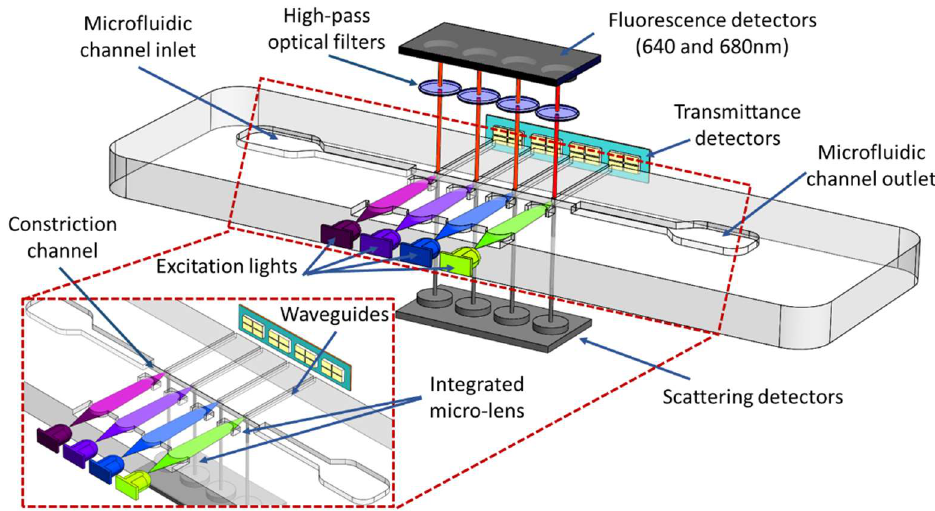
Figure 15. Schematic illustration of the lab-on-a-chip for phytoplankton group identification and quantification based on fluorescence detection.